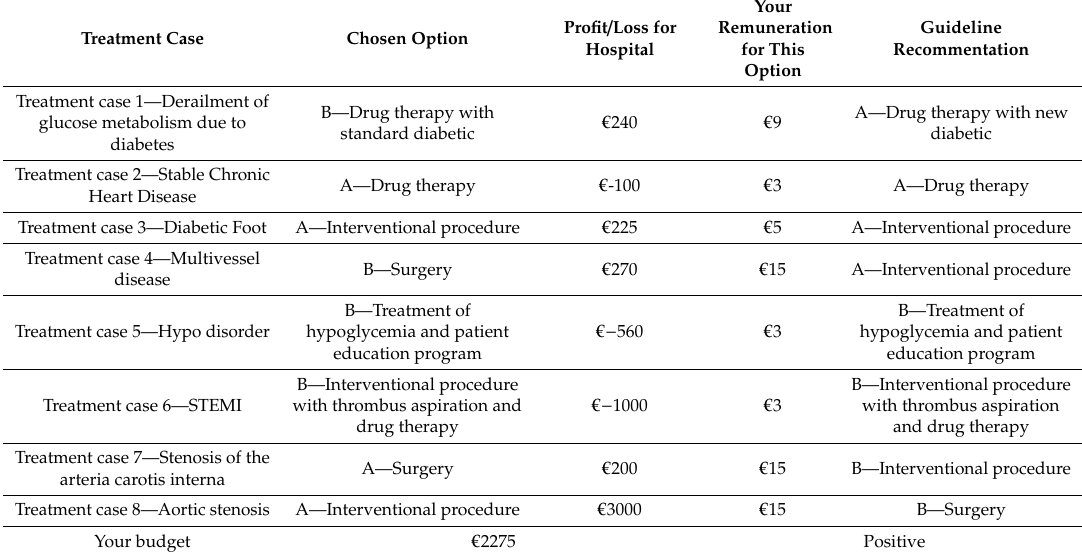
Table A8. Example—Screenshot of Overview of Preliminary